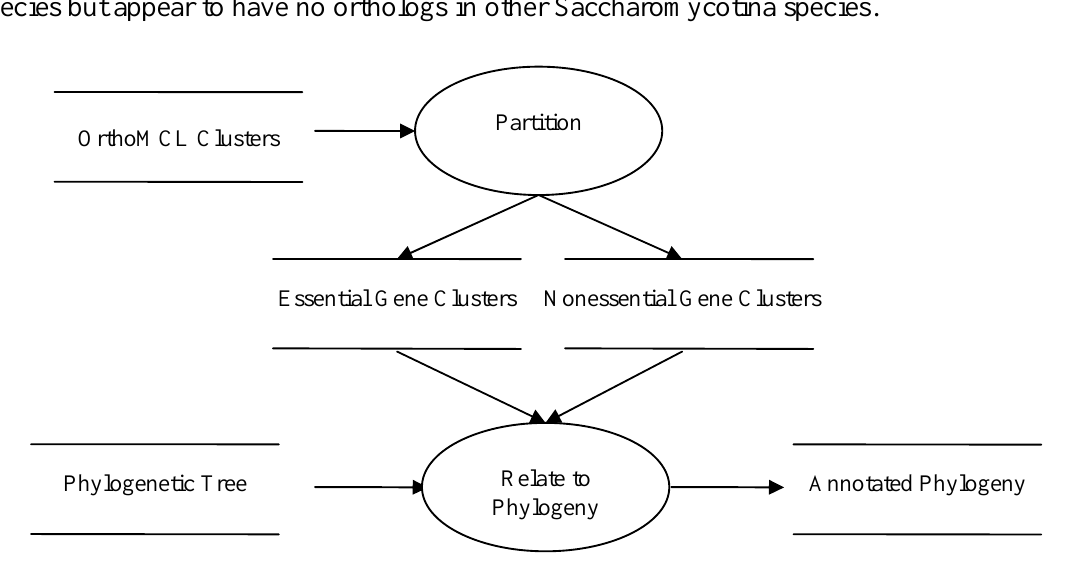
Figure 5: A data flow diagram for studying conservation of essential